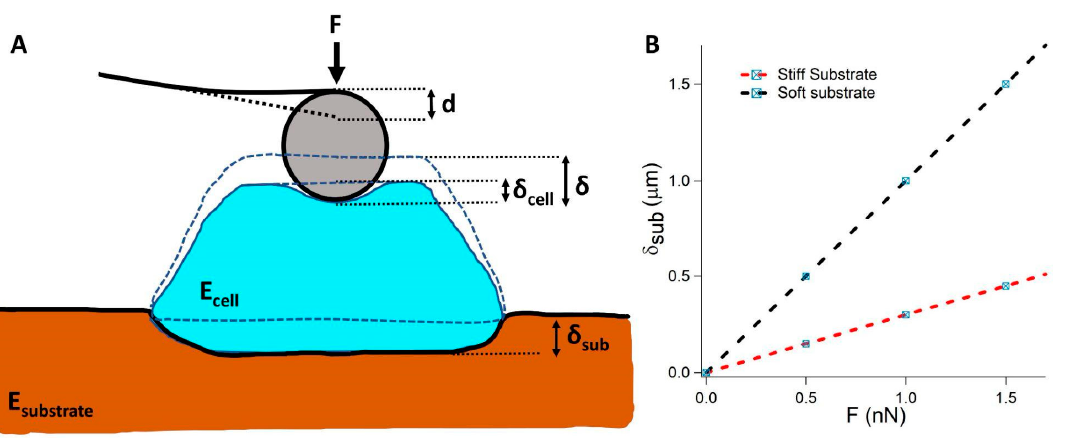
Figure 3. ( A ) Very soft substrates are softer than cells. In this case, when the cell is pushed on the substrates in a force spectroscopy experiment, the cell is acting as an indenter penetrating the soft substrate. ( B ) The indentation increases linearly with the force increase; the slope is higher on softer substrates. Adapted from Ref. [66].